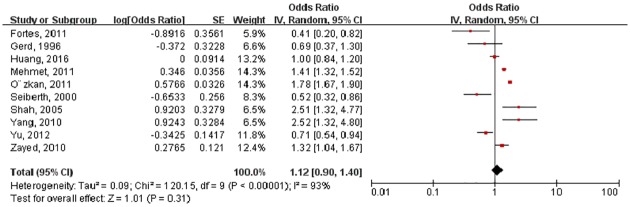
Forest plot showing the association between any stage retinopathy of prematurity and hypertensive disorders in pregnancy.